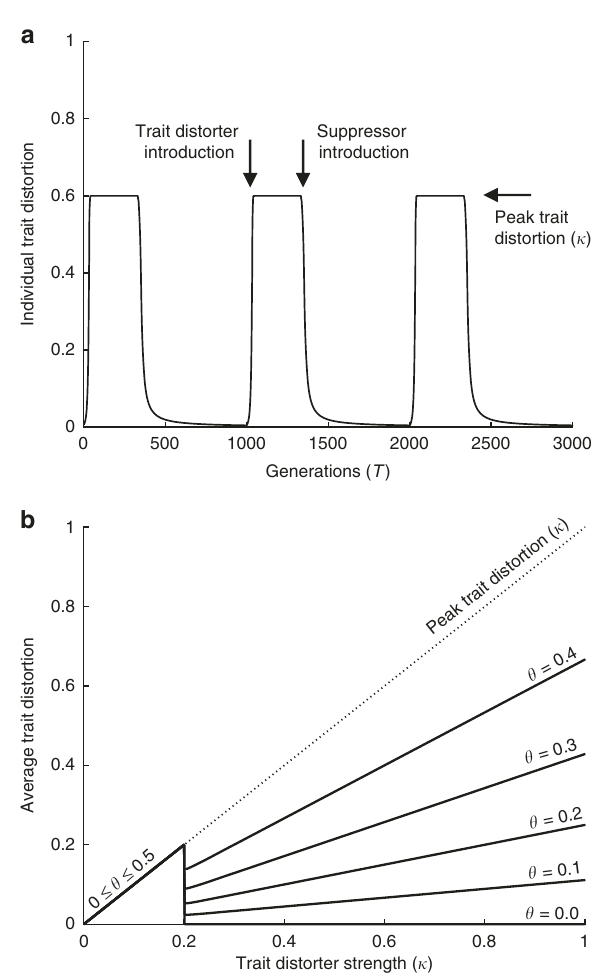
Fig. 4 The dynamics of con fl ict when trait distorters do not co-segregate. a plots individual trait distortion over evolutionary time, for trait distorters of strength k = 0.6. We introduced trait distorters ( D 1 ) deterministically at Þ generations, and their dedicated suppressors after new loci every 1 = ð θγρ D 1 Þ generations. Individual trait distortion increases and a lag of 1 = ðð 1 (cid:3) θ Þ γρ S 1 decreases cyclically over evolutionary time, between peaks of k and troughs of 0. b plots average trait distortion for different proportional cabal sizes ( θ ), against the strength of trait distorters available to the cabal ( k ). Below a certain threshold strength ( c sup > c trait ( k )), suppressors do not invade, and so the resulting trait distortion increases with the strength of the trait distorter ( k ), and is unaffected by proportional cabal size ( θ ). Above this threshold ( c sup < c trait ( k )), suppressors are favoured, and average trait distortion is approximately given by Eq. 6, increasing with trait distorter strength ( k ), although less appreciably for decreased proportional cabal